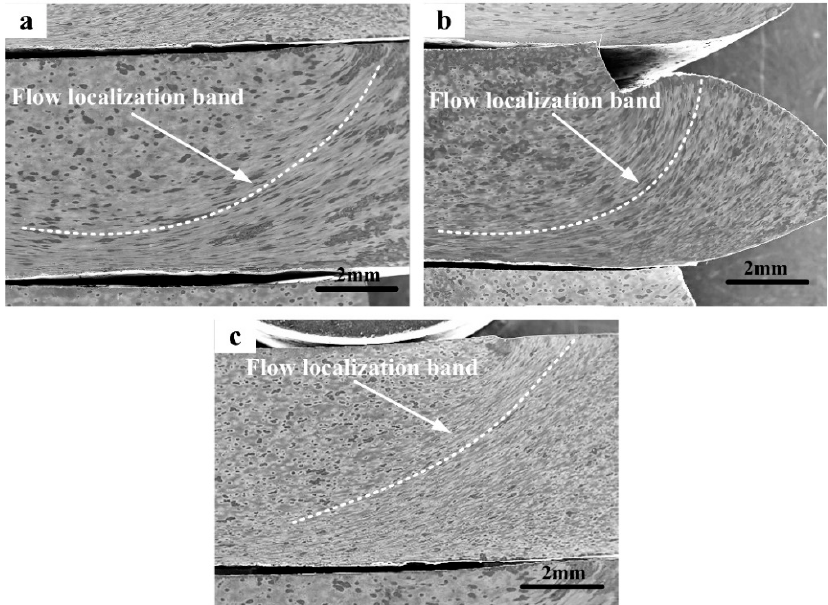
Figure 4. SEM images showing the flow localization situations of the unstable deformed PM Ti-5553 alloy specimens: ( a ) 700 °C/10 s − 1 ; ( b ) 600 °C/1 s − 1 and ( c ) 700 °C/1 s − 1 .